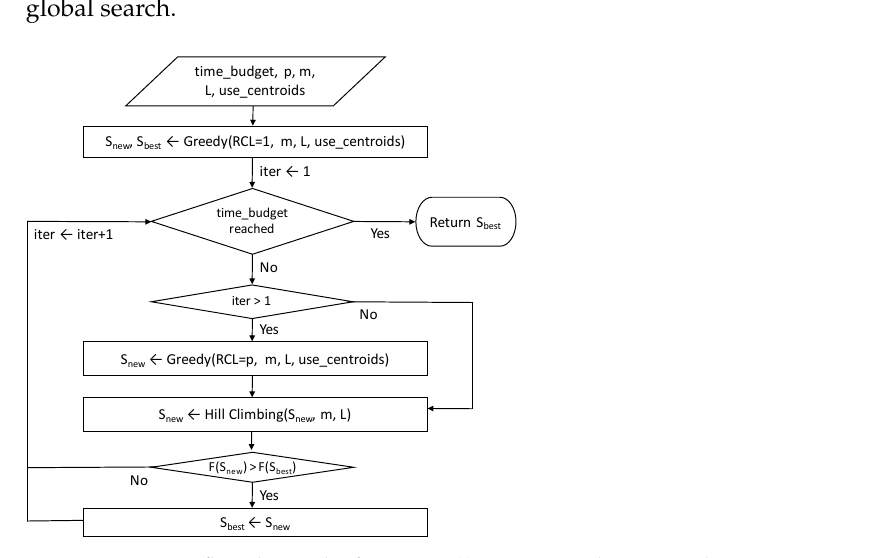
Figure 5. GRASP flowchart. The function F(.) represents the accumulative score.